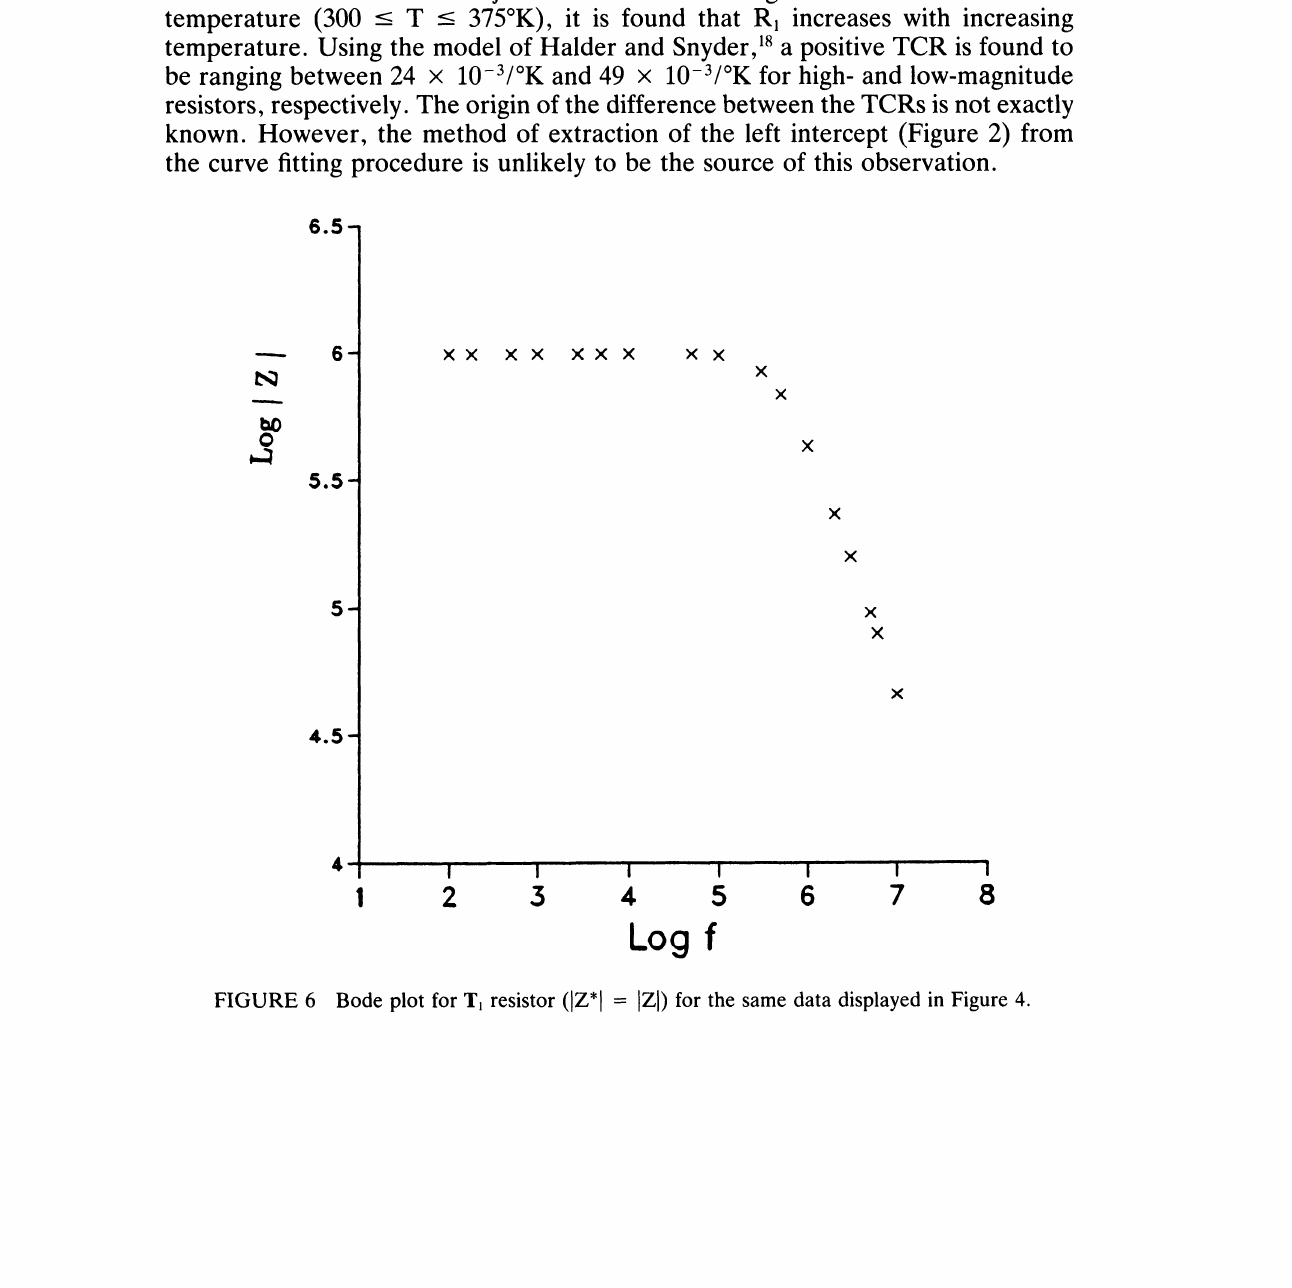
FIGURE 6 Bode plot for T, resistor (IZ*I IZI) for the same data displayed in Figure